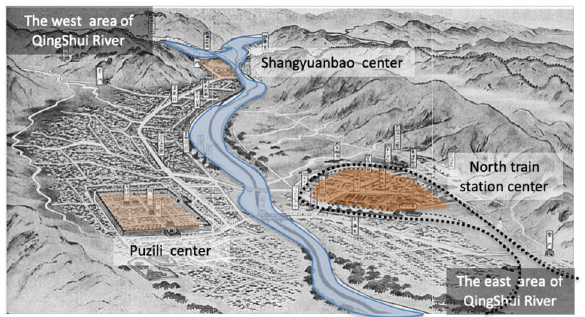
Fig. 3 A new commercial center was formed near Zhangjiakou North Station. Source : Drawn by the authors